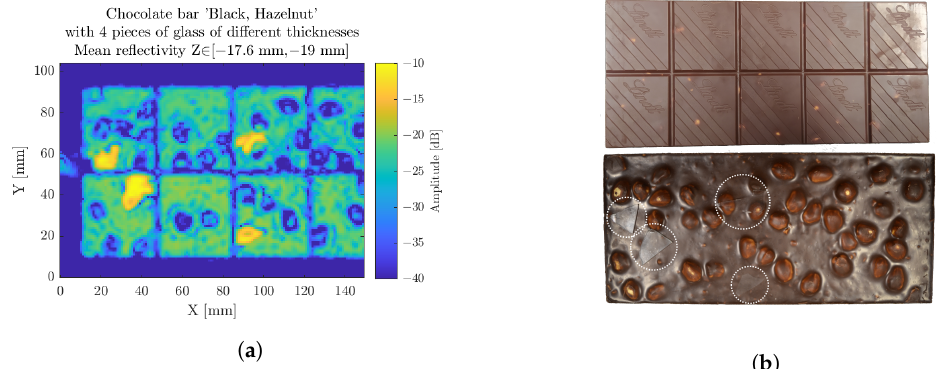
Figure 15. The chocolate hazelnut bar scan, considered on a longitudinal range of interest on the backside ( a ). Photography of the front and back sides of the sample ( b ).